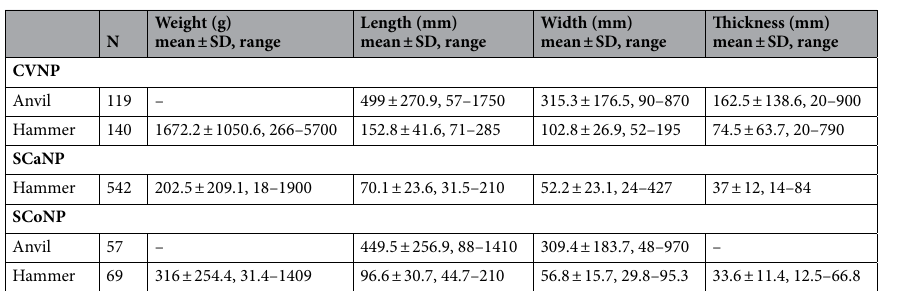
Table 1. Pounding stone tools and anvil general dimension for each site, presenting average, standard deviation, and range values. Sources: CVNP —Chapada dos Veadeiros National Park (this work), SCaNP — Serra da Capivara National Park 19,31 , SCoNP —Serra das Confusões National Park 6 . Anvil data for SCaNP is not presented because the previous work on the site did not register that measurement.